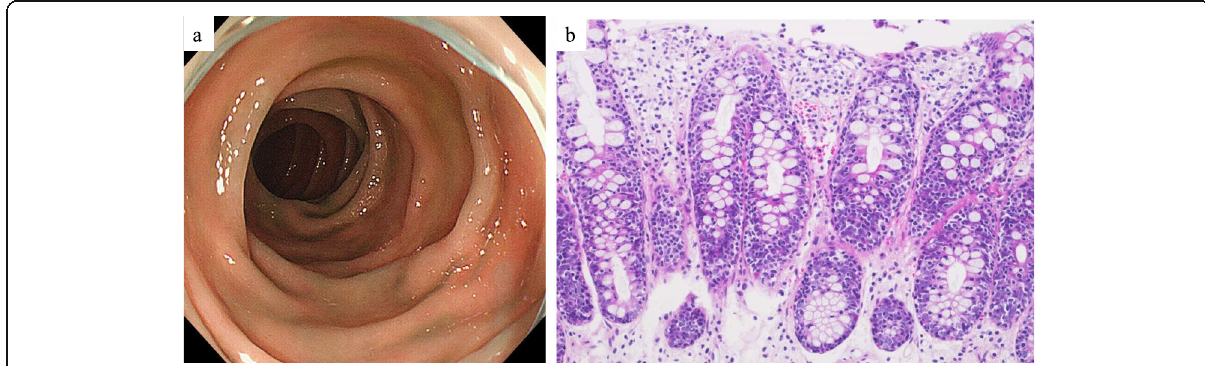
Fig. 3 Lower GI endoscopic and histologic findings of features of lymphocytic colitis in MEITL. a Endoscopic view of the descending colon showing mild edematous mucosa. b Histological analysis showing many scattered small IELs and no overt stromal invasion by lymphoma cells (hematoxylin and eosin stain, ×